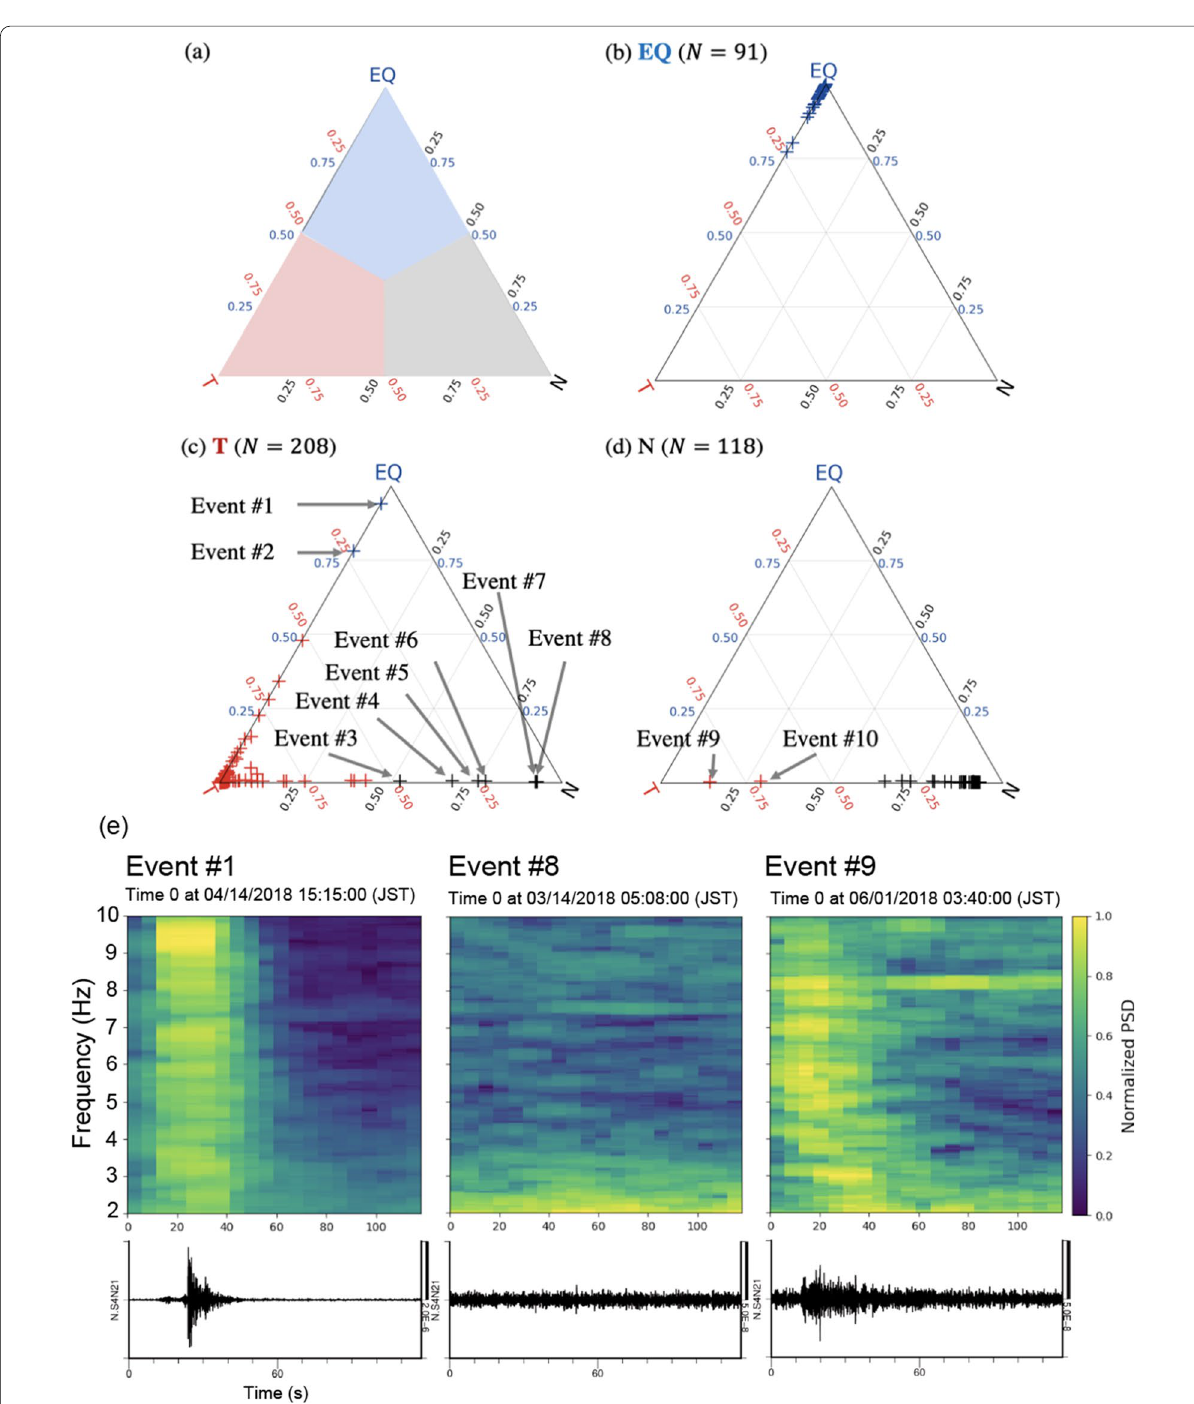
Fig. 3 Ternary plots for the EQ–T–N classification. Each cross mark represents the output probability for a given event. a Ternary plot highlighting the EQ–T–N classification regions. The blue, red, and gray regions correspond to the predicted EQ, T, and N labels, respectively. b Ternary plot for events with actual EQ labels. c Ternary plot for events with actual T labels. d Ternary plot for events with actual N labels. Events #1–#10 denote events for which the predicted labels are different from their actual labels (Table 1 and Additional file 1: Fig. S1). e X-component spectrograms and seismograms of the events with different actual and predicted